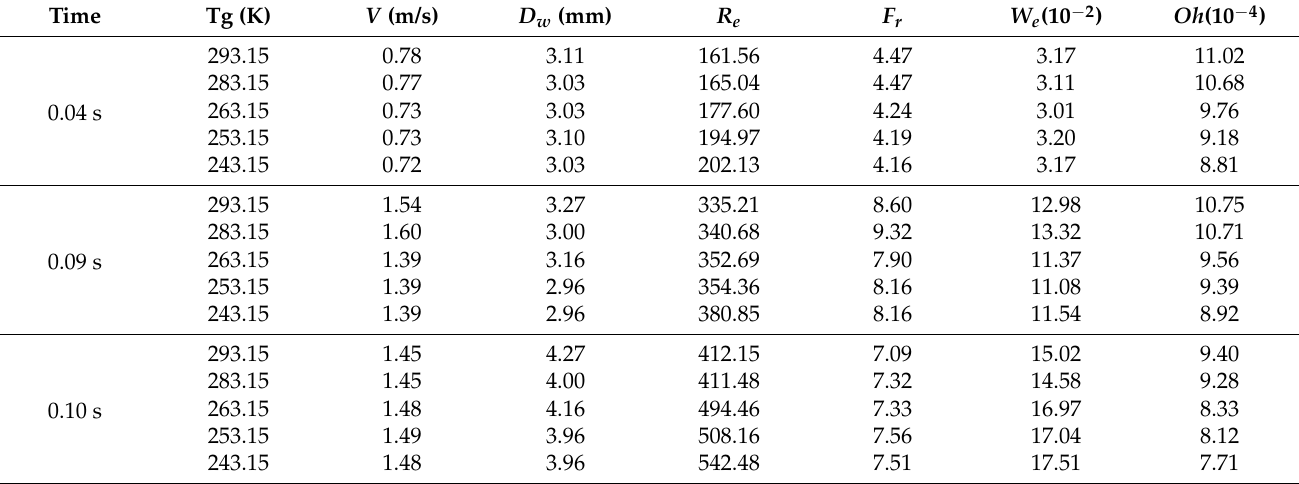
Figure 6. The velocity of the free-falling water droplet in air at different temperatures. Table 3. Parameters of the free-falling water